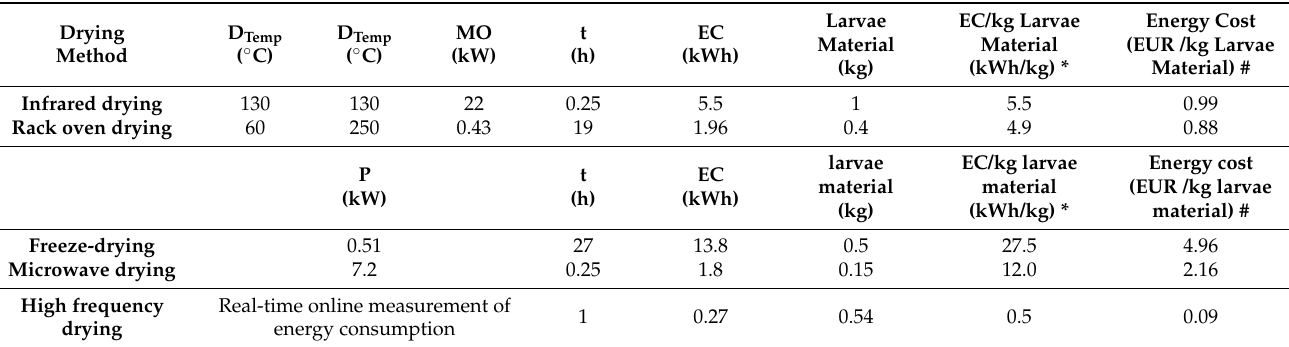
Table 1. Energy demand of the different drying methods.